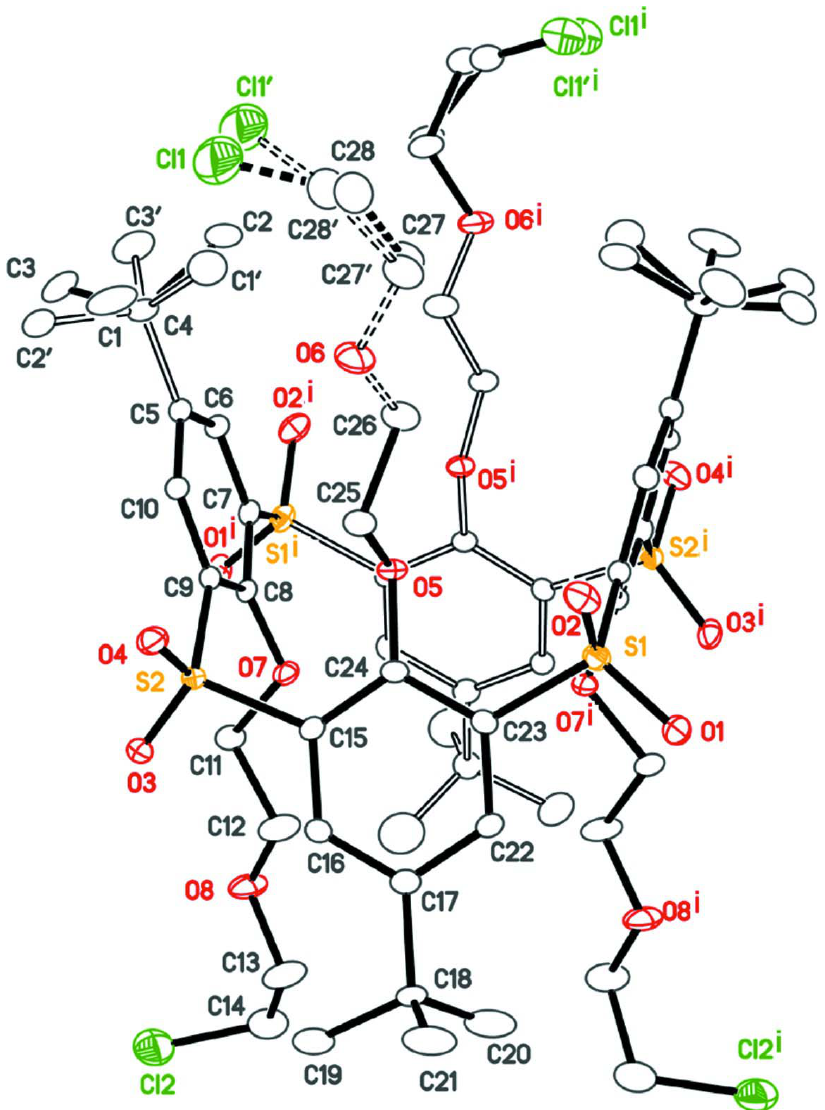
Figure 1 The molecular structure of the title compound with displacement ellipsoids drawn at the 30% probability level for non-H atoms. The disordered atoms are shown, but hydrogen atoms are omitted for clarity. [Symmetry code: (i) - x + 1, y , - z +